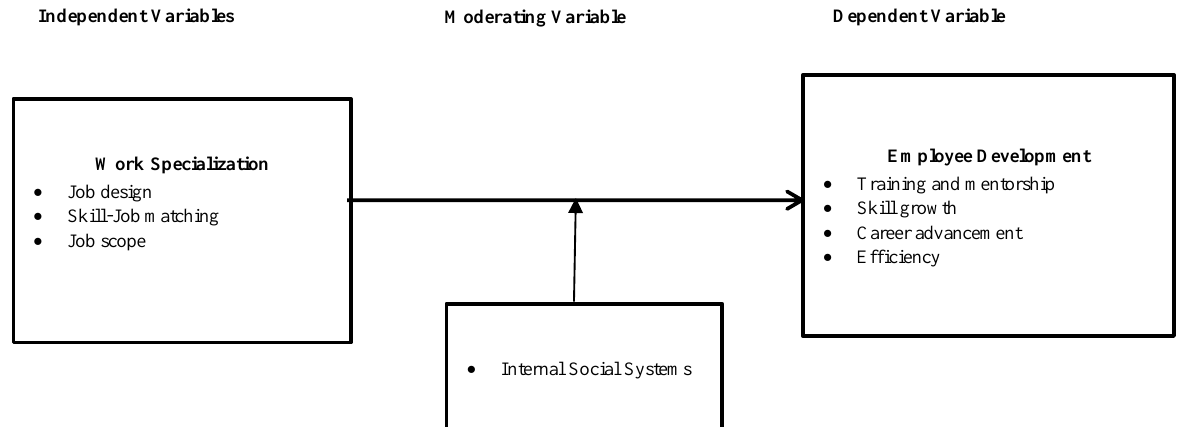
Figure 1: Influence of Work Specialization on Employee